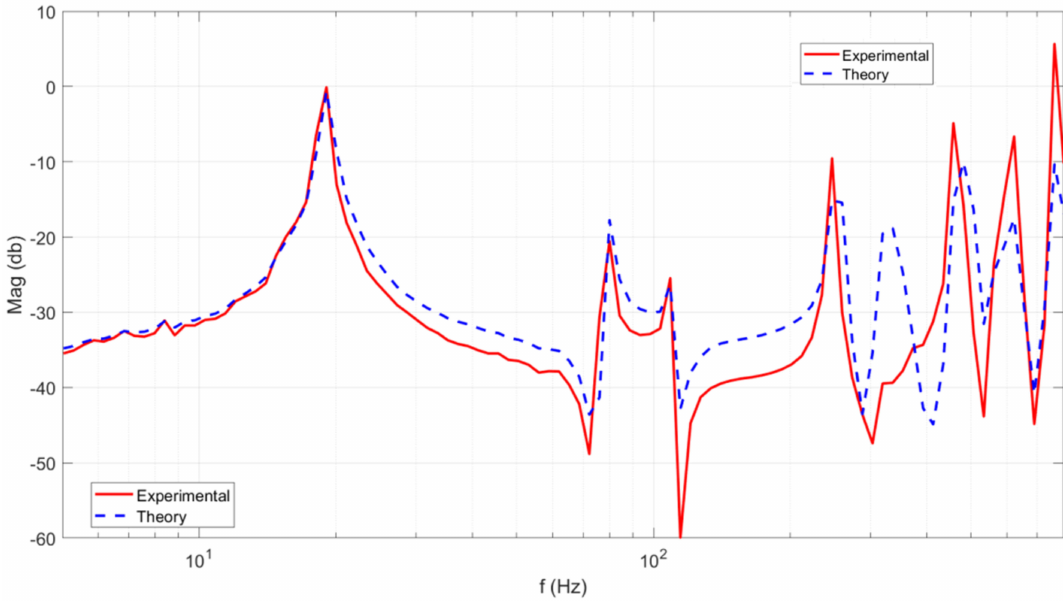
Figure 2. Comparison of magnitude of frequency response function of the free plate, for theory and